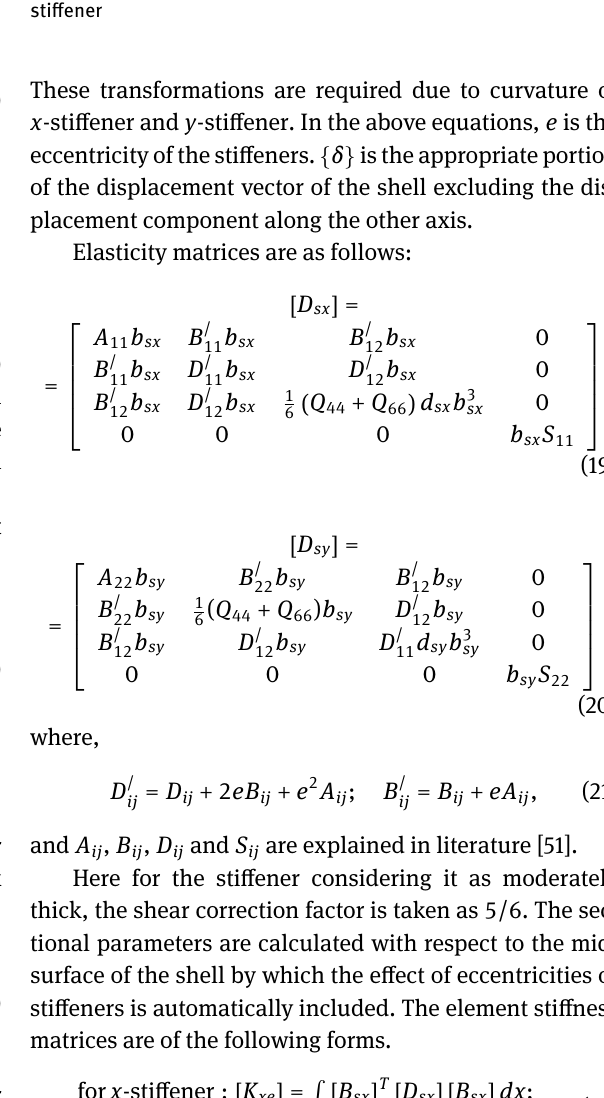
Figure 2: (a) Eight noded shell element with isoparametric co- ordinates (b) Three noded stiffener elements (i) x-stiffener (ii) y- stiffener